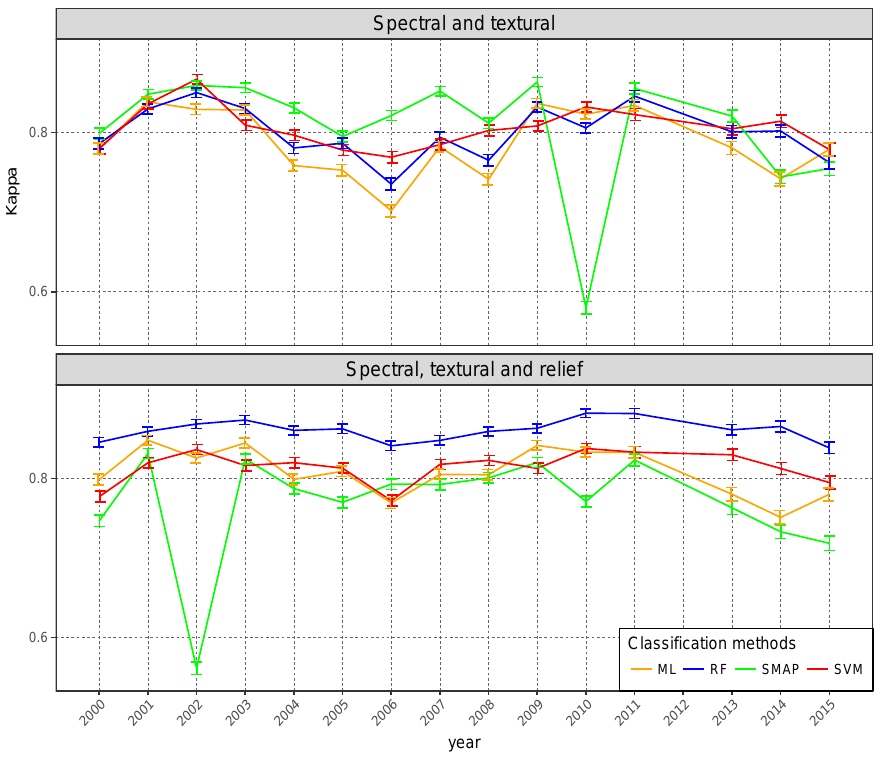
Figure 7. Validation kappa series with 95% confidence intervals for the four algorithms and the three feature combinations, using four, three or two seasons depending on their availability. Number of classifications: 180.